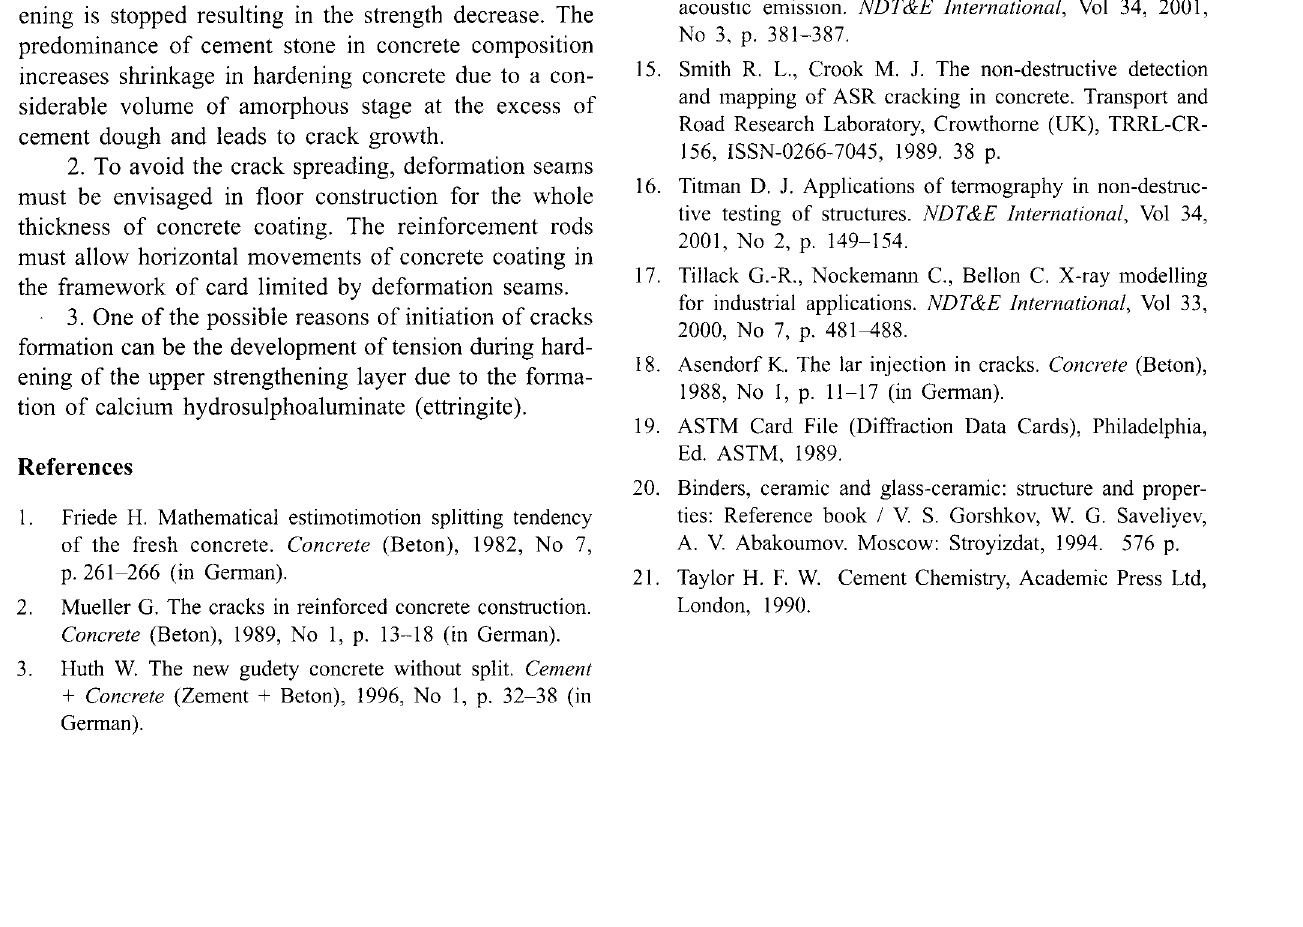
separate cards via the overall depth (including reinforced net) for developing deformation seams. It will allow to